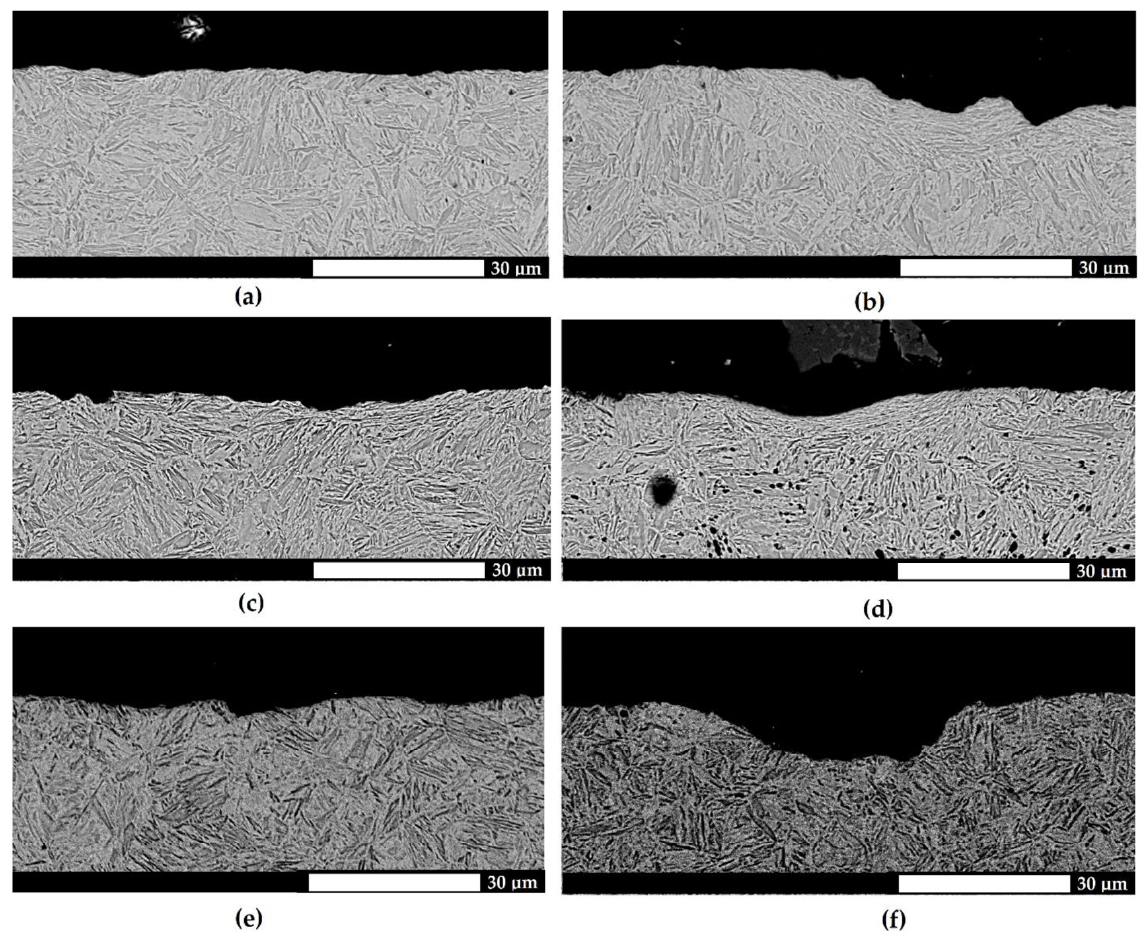
Figure 8. Microstructures of the surfaces subjected to testing for the abrasive wear of Hardox 600 steel on a cross section transverse to the direction of the abrasive action. ( a , b ) light soil; ( c , d ) medium soil; ( e , f ) heavy soil. The surface is relatively smooth, and the distortion of martensite blocks can be observed. Electron microscopy, etched with Mi1Fe (Nital).